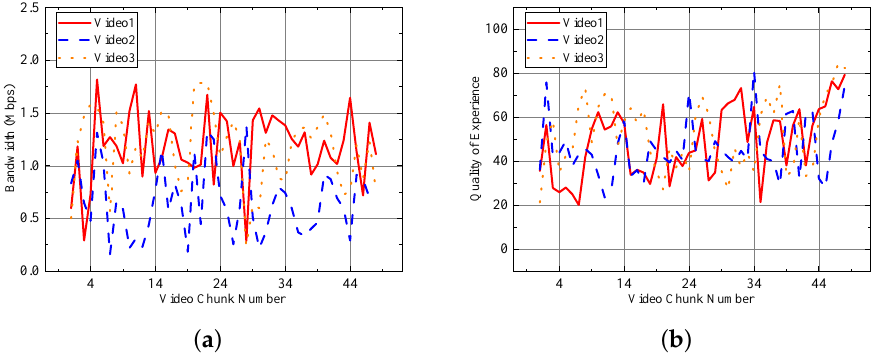
Figure 5. ( a ) Evolution of bandwidth in FBAC ( b ) Evolution of QoE in FBAC.